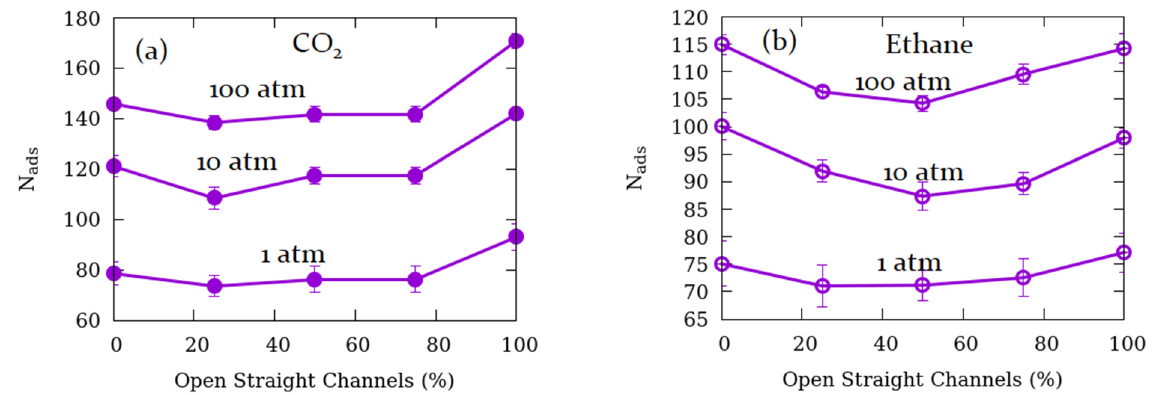
Figure 5. Number of fluid molecules ( a ) CO 2 and ( b ) ethane adsorbed in systems with half of the pore space in the unmodified silicalite blocked/free (systems in the portion of Table 1 highlighted in yellow), as a function of the percentage of straight channels that are open. The X -axis can also be read as the percentage of open zigzag channels, decreasing from 100 (left-most data point) to 0 (rightmost data point).